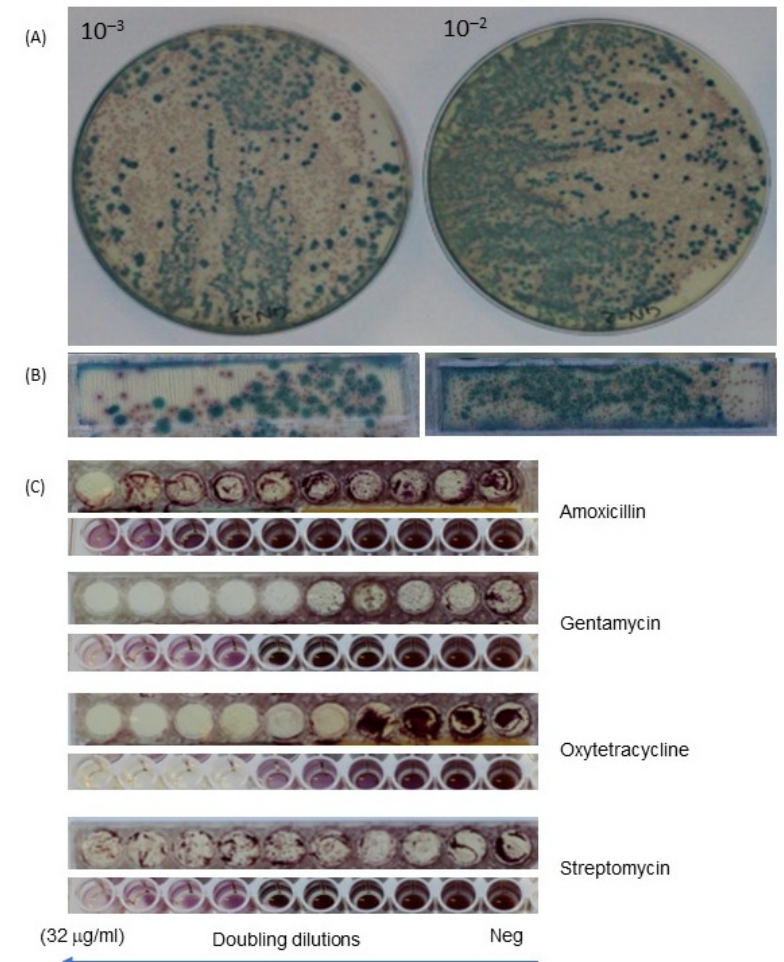
Figure 5. Comparison of identification and determination of MIC through frame dip slide vs. Petri dish combined with broth microdilution on mastitis milk sample . ( A ). Bacteria ( E. coli —pink colonies, Klebsiella —blue colonies) grown on CHROMagar™ Mastitis (CHROMagar™, Paris, France) at two dilutions on Petri dish, ( B ) Bacteria grown at two dilutions on frame, ( C ) Comparison of the results of MIC between frame (upper image for each antibiotic) and broth microdilution (lower image).